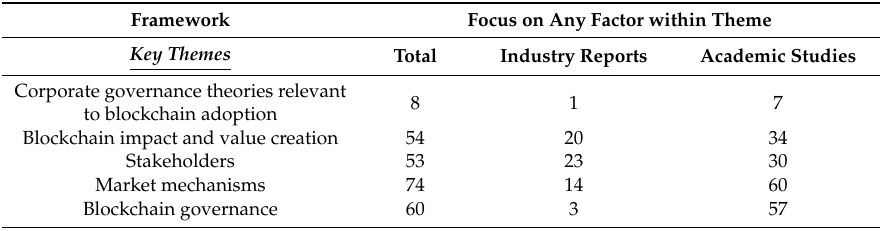
Table 2. Focus counts for framework development from prior literature.